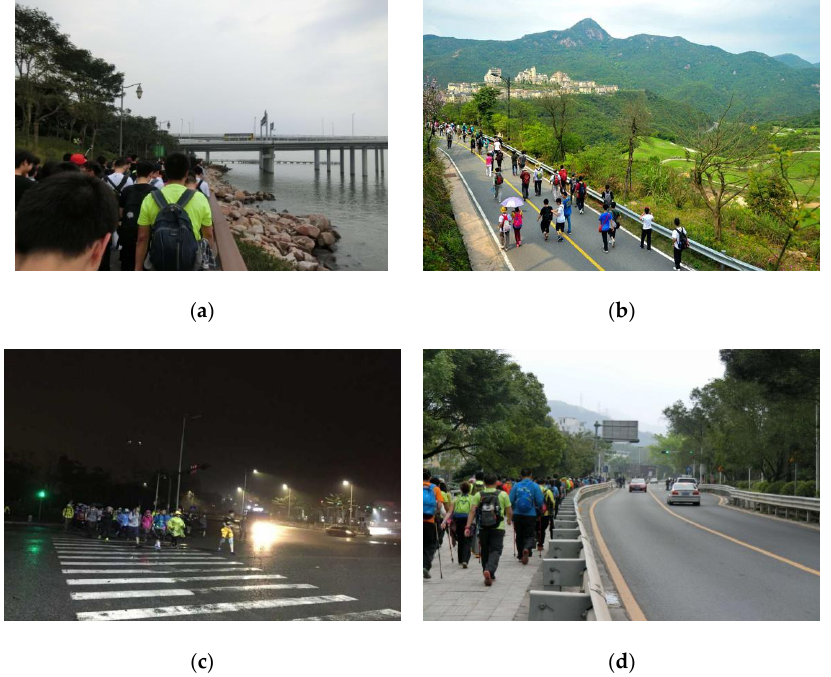
Figure 2. The typical walking environment of the 2016 “Shenzhen 100 km Walking” event [65]: ( a ): Ocean Bay; ( b ): mountain area; ( c ): urban area (walking in the night); ( d ): rural area.